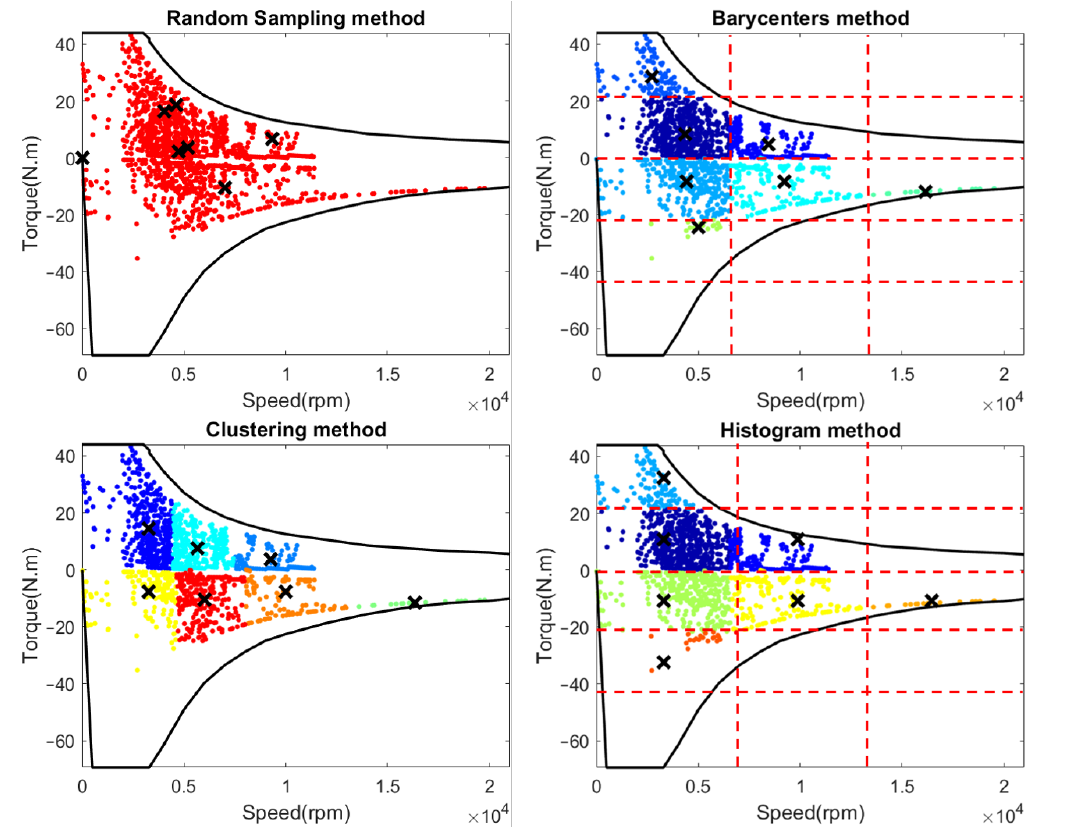
Figure 11. Application of different cycle reduction